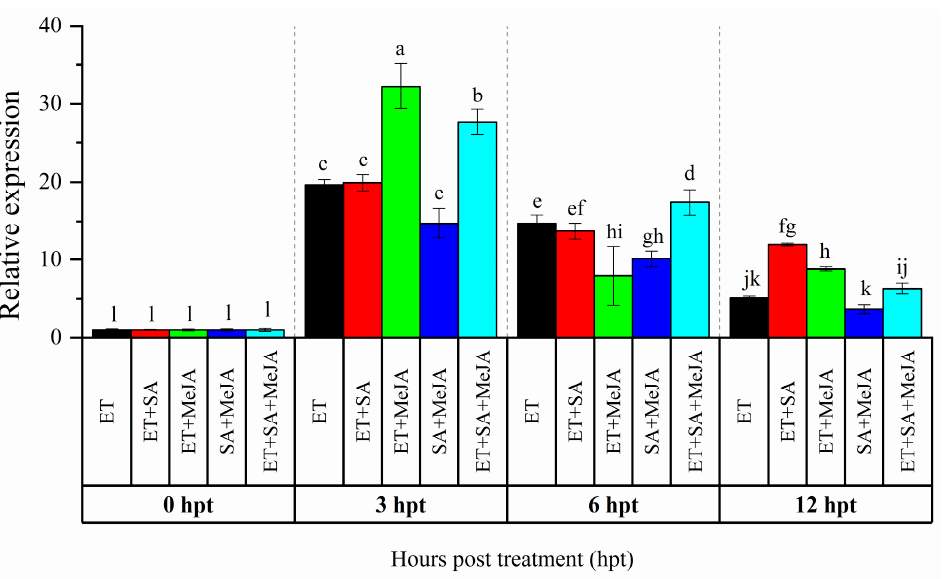
Figure 1. Expression analysis of CaAP2/ERF064 in response to various combinations of phytohormones. Values are means ± SD. Small letters indicate a significant difference (least significant difference (LSD), p < 0.05).